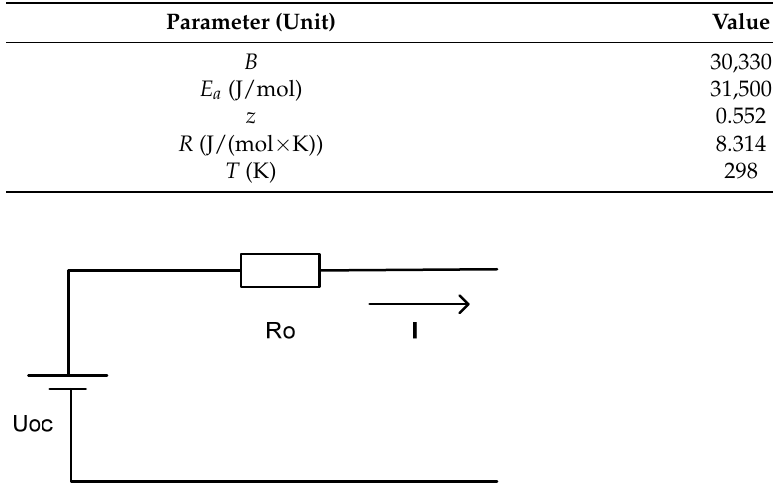
Figure 4. The battery Rint model.